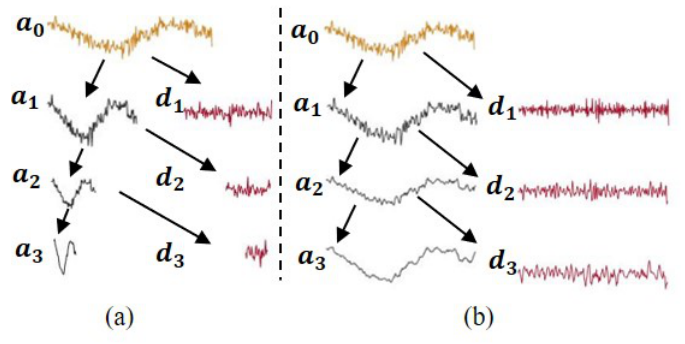
Figure 3. ( a ) Discrete/DWT decomposition and ( b ) stationary/UWT